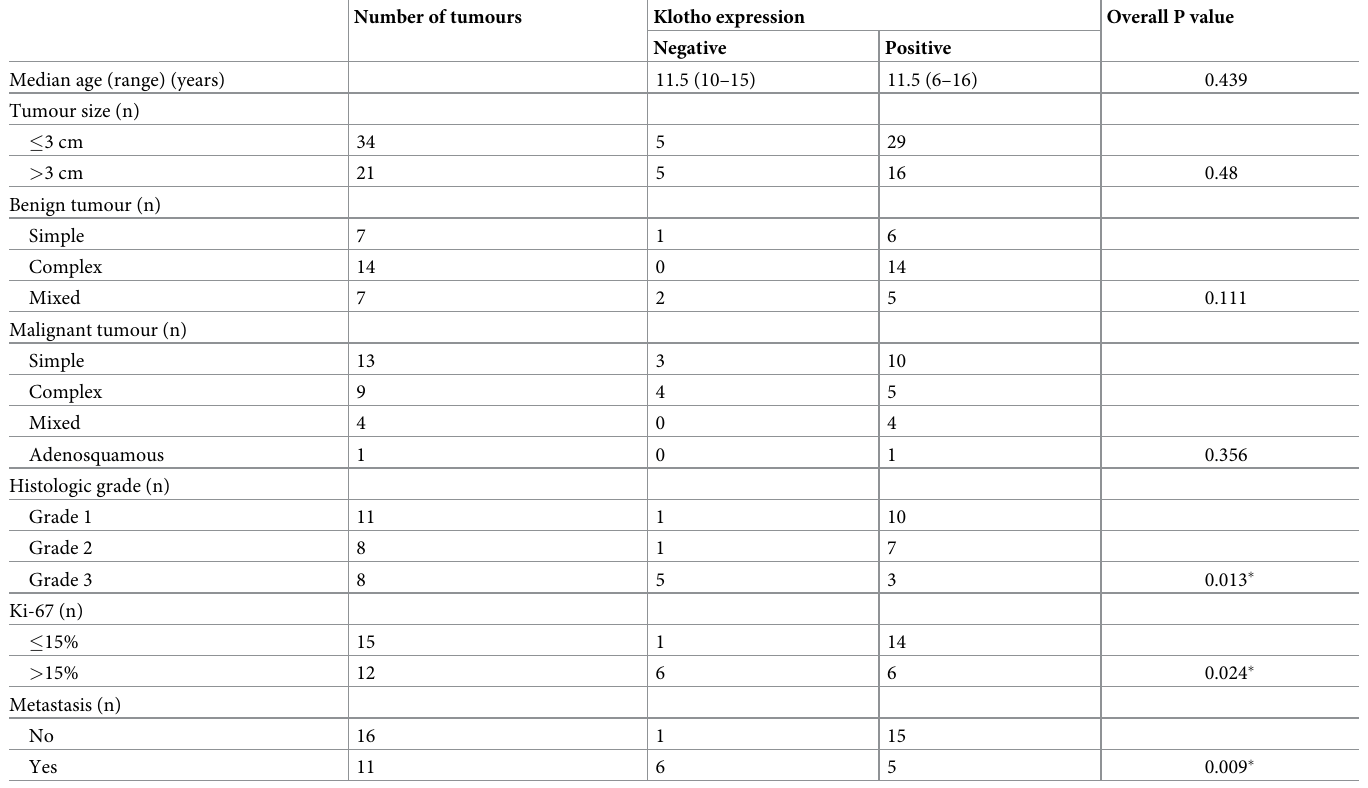
study has shown the expression of klotho protein in the kidney, reproductive organs, and brain of mice [29]. In human tissues, klotho expression was identified by immunohistochemis- try in arterial, epithelial, endocrine, reproductive, and neuronal tissues [30]. Klotho has also been identified in normal human breast tissues. Although the exact physiological function of klotho in mammary glands has not yet been revealed, in addition to its function as a modulator of IGF-1 and FGF, klotho’s ability to activate calcium channels is believed to regulate the cal- cium concentration in milk [6]. It is the first study to observe klotho expression in canine mammary glands. Immunostaining for klotho was mainly seen in the cytoplasm and plasma membrane of epithelial cells. This is supported by studies showing that klotho is also a Table 3. Clinicopathological variables associated with klotho